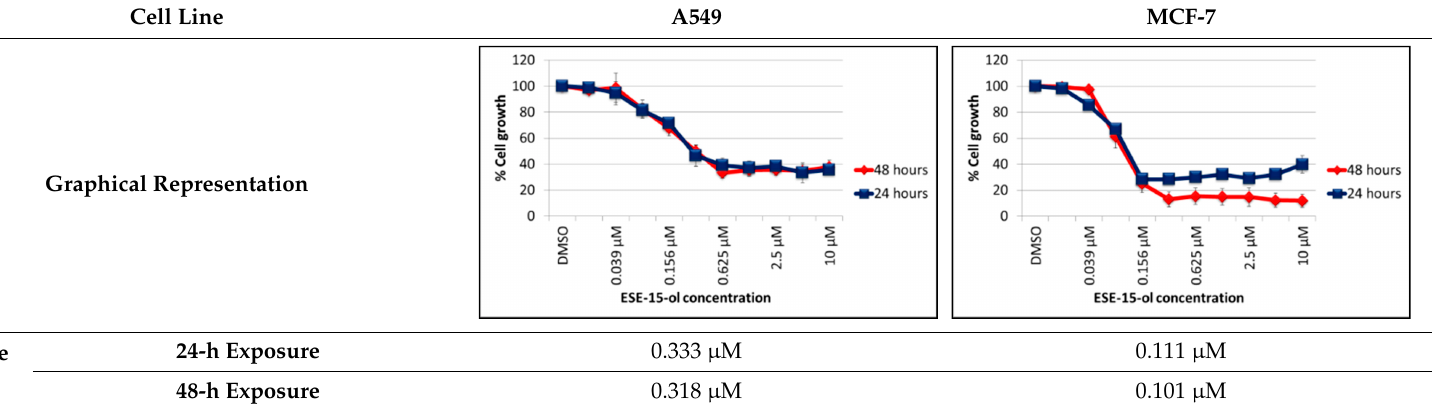
Table 1. Dose response curves of A549- and MCF-7 cells exposed to ESE-15-ol for 24- and 48-h. No statistical significant differences were calculated between GI 50 values determined at different exposure times.